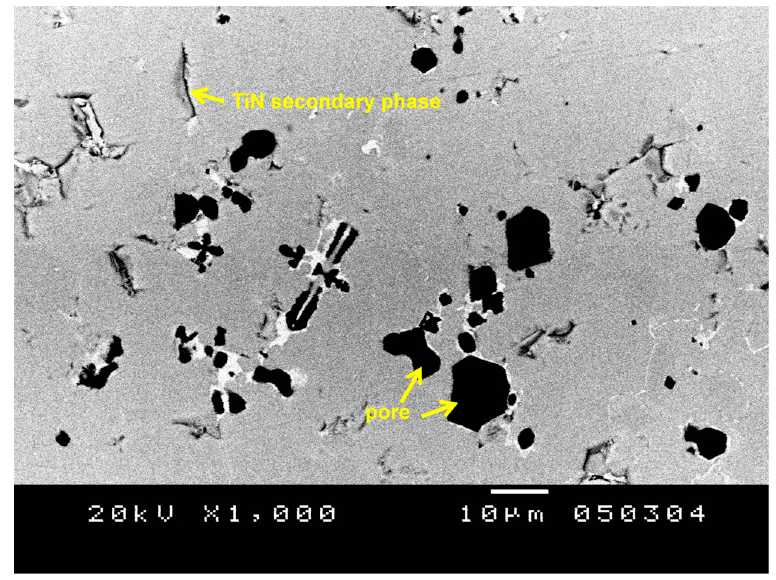
Figure 2. SEM BSE (scanning electron microscopy back-scattered electron) image of the surface of TiNiSn-10TiN alloy.